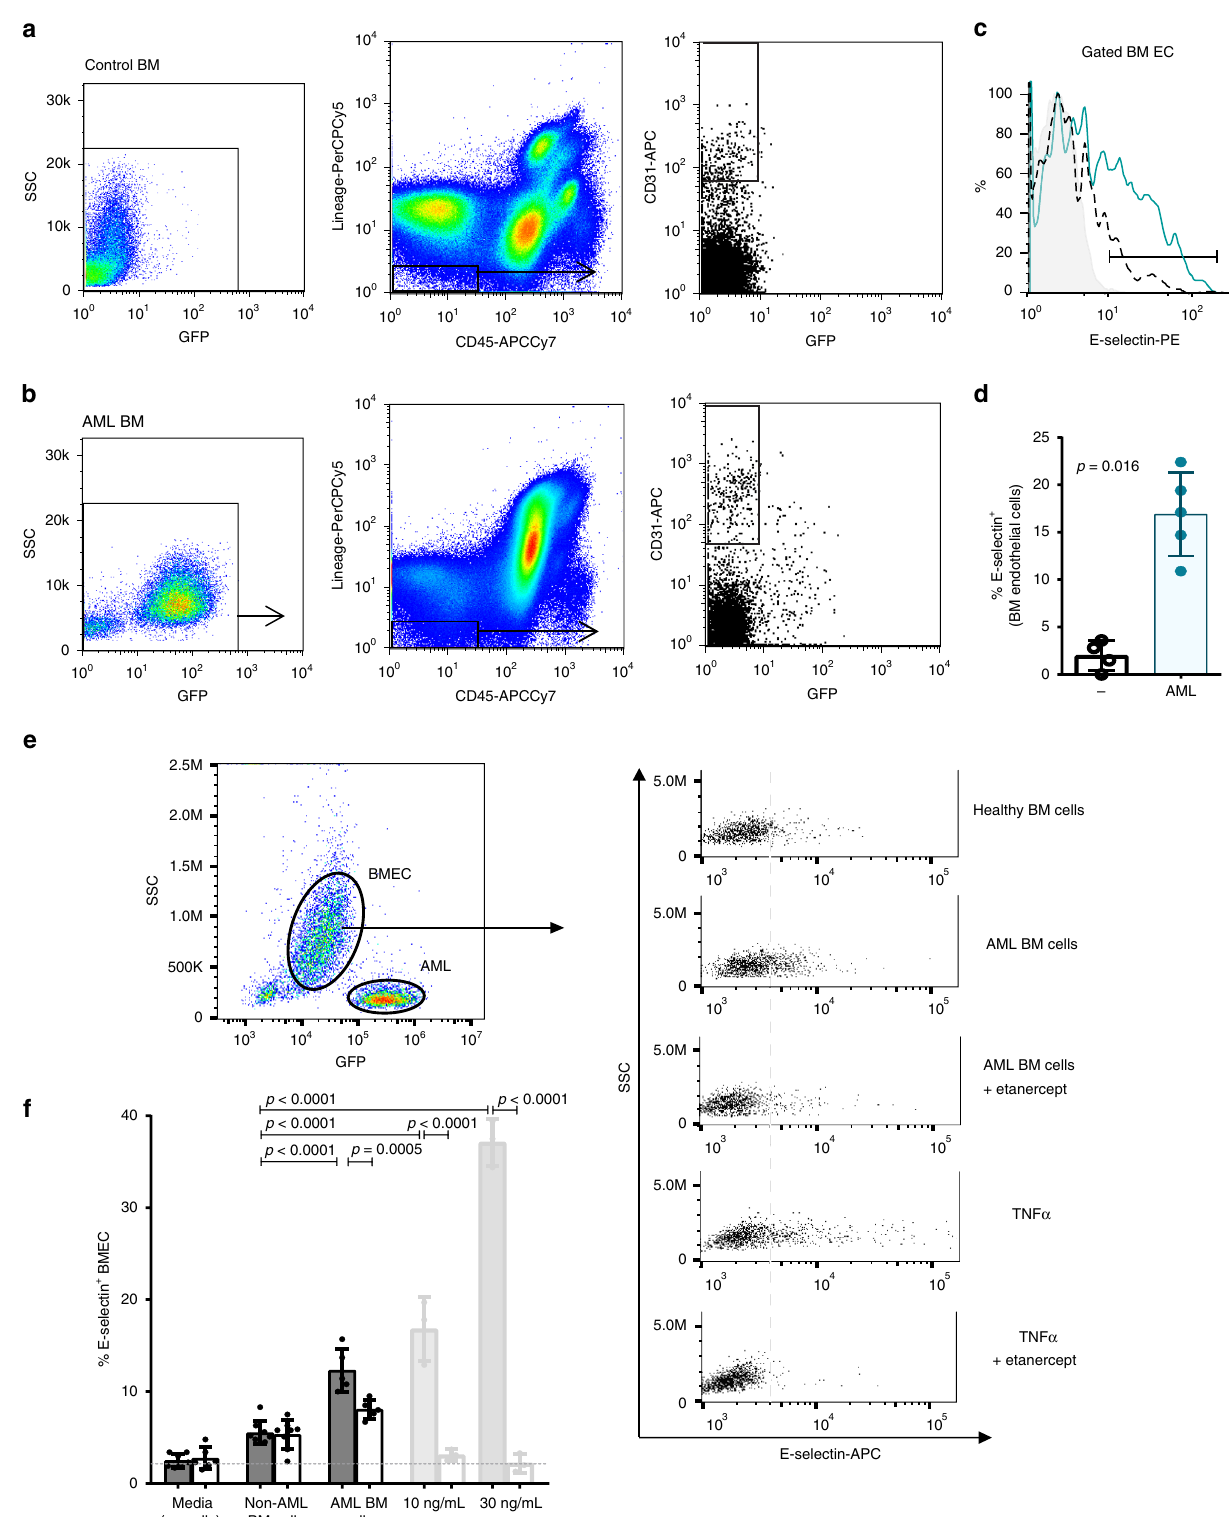
endogenous HSPCs was observed following GMI-1271 adminis- tration (Fig. 2c, right). These data suggest that E-selectin- mediated interactions may play some role in the retention of AML blasts within the BM niche, but not in HSPC retention. Despite this, when compared to the total number of AML